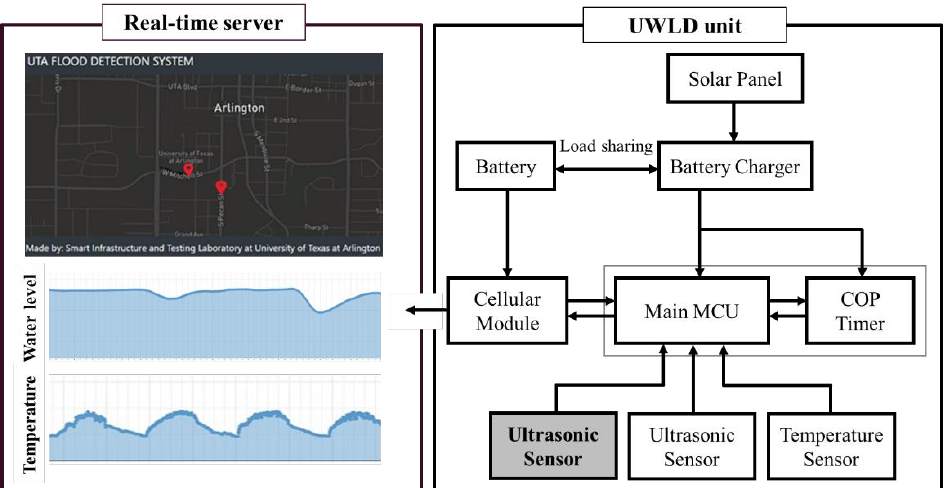
Figure 5. System representation of UWLD-2 with dual-target sensing. The additional ultrasonic sensor is deployed for monitoring the pavement side water level. The moving median filtered distance data from the pavement side sensor is also transferred to the cloud server.